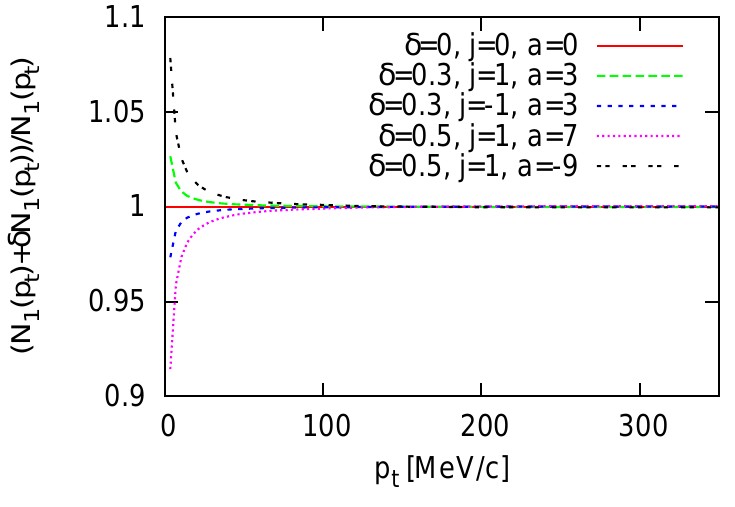
Figure 2. The ratio of the original and the perturbatively corrected single-particle transverse momentum distribution for the investigated solution. The model parameters of the original Hubble-flow come from fits to experimental data